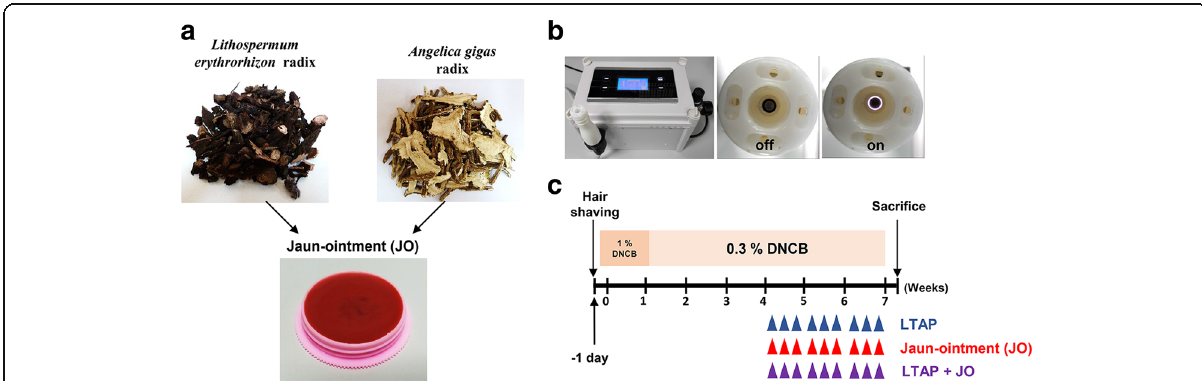
Fig. 1 A brief introduction of Jaun-ointment (JO) and low-temperature argon plasma (LTAP) device and the experimental design. a Photographs showing the appearance of Angelica gigas Nakai radix and Lithospermum erythrorhizon Siebold & Zucc radix , two main components of JO. b The figures of LTAP device used. c Schematic diagram of the experimental protocol in a mouse model. NC/Nga mice were divided into four groups: non-treated control (nt), DNCB-induced AD-like symptoms (DNCB), DNCB-induced AD-like symptoms treated with JO (DNCB-JO), and DNCB-induced AD-like symptoms treated with LTAP and JO